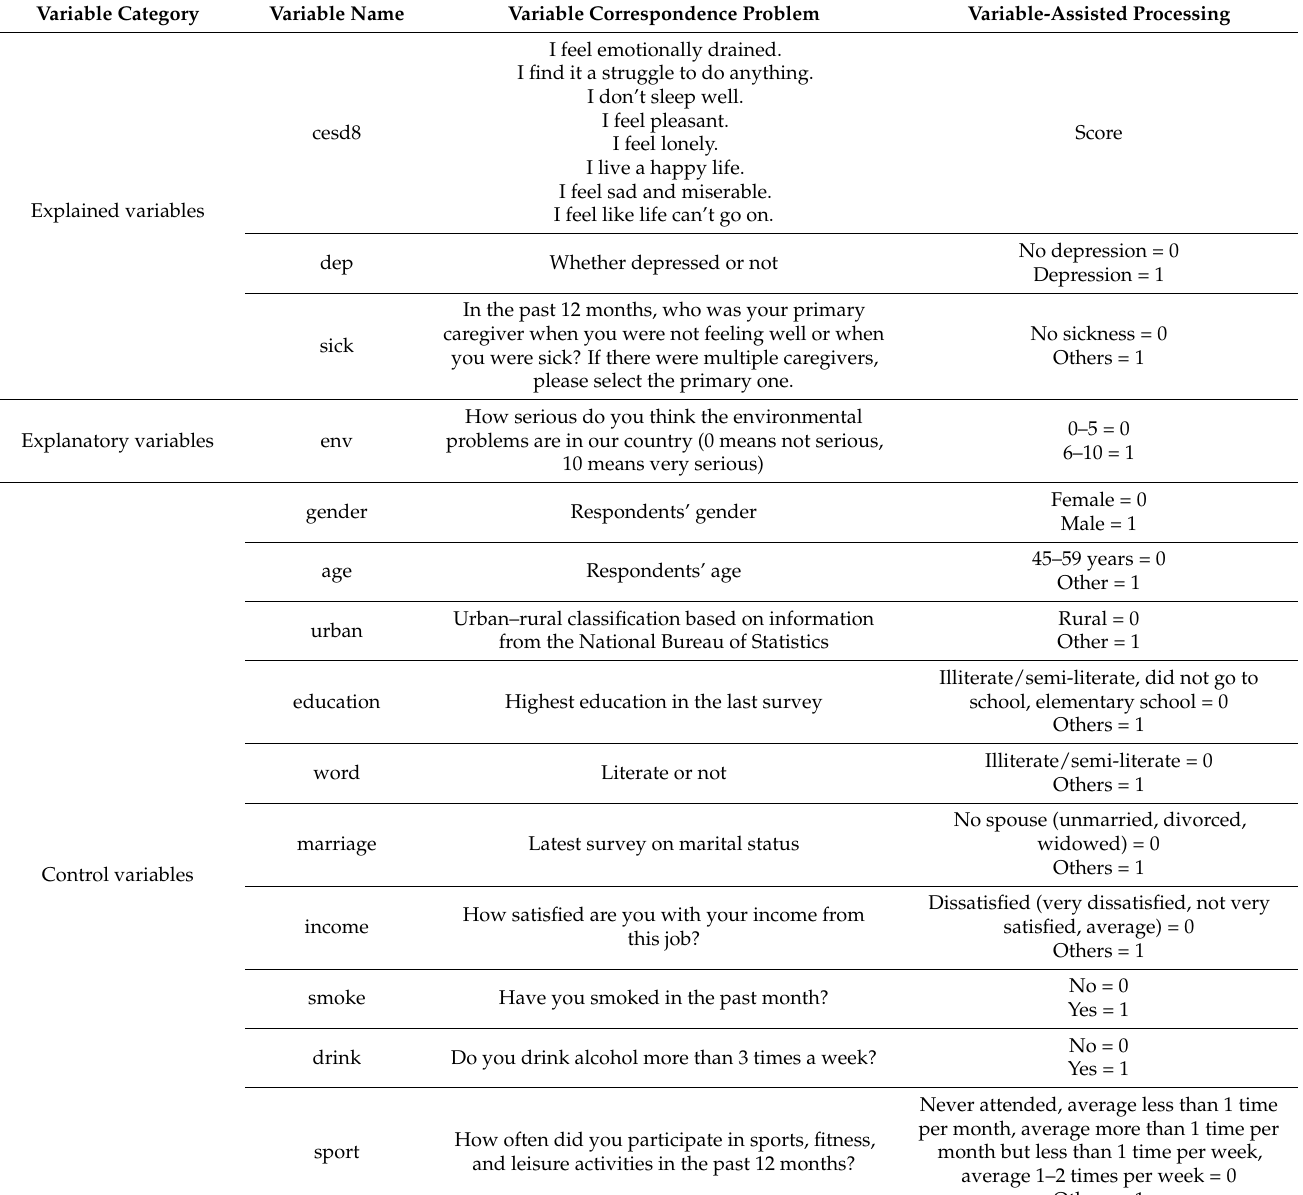
Table 1. Variable